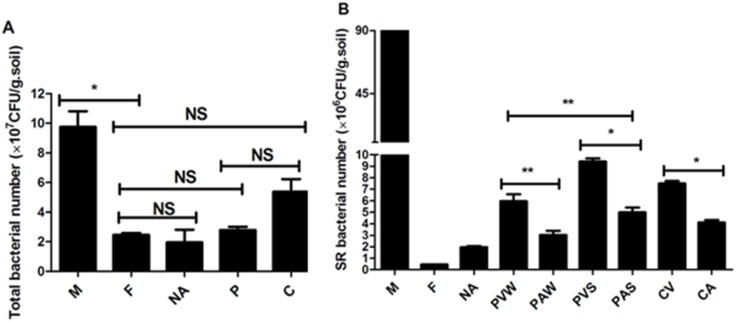
Numbers of cultivable bacteria.(M = Manure, F = Forest, NA = non-arable fied, P = Pig, C = Chicken, W = winter, V = vegetable garden soil, A = agricultural soil; *p≤0.05, **p≤0.01, n = 3; NS, not significant).